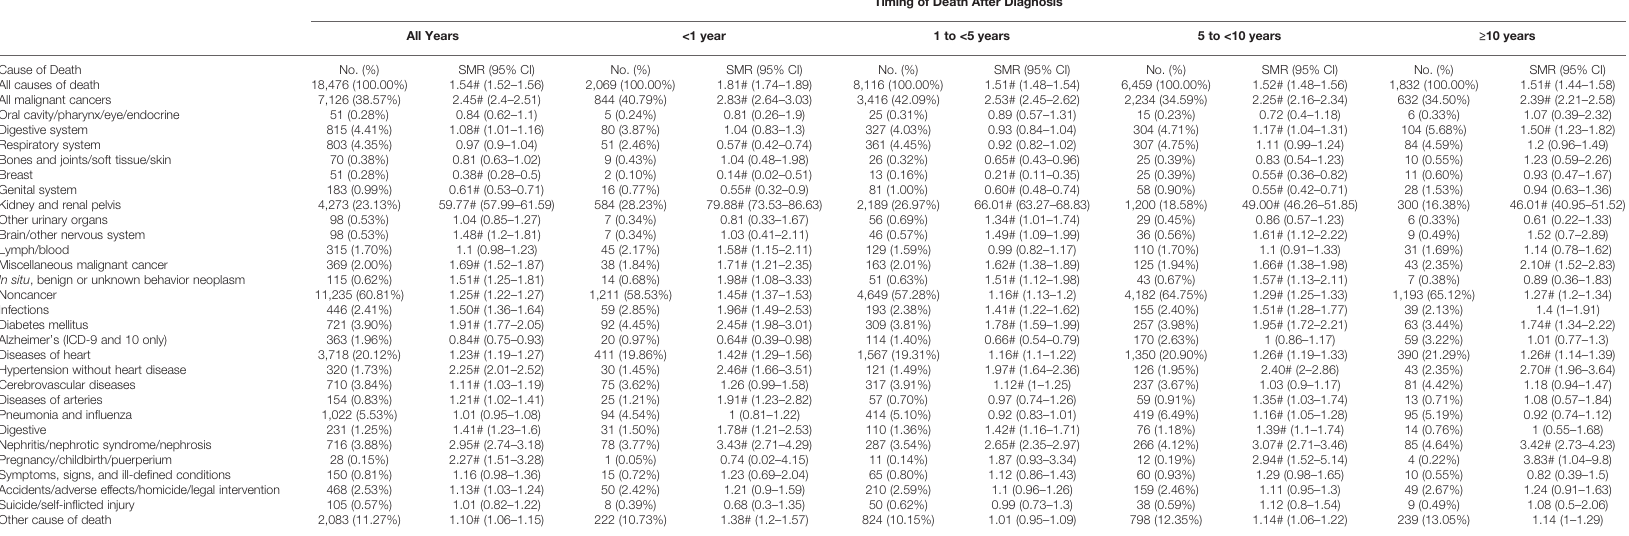
TABLE 2 | Causes of death for patients with stage I/II RCC.